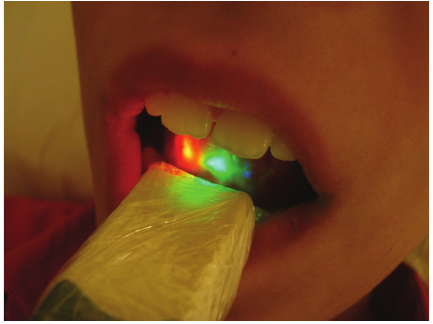
Figure 3: Sublingual laser blood irradiation